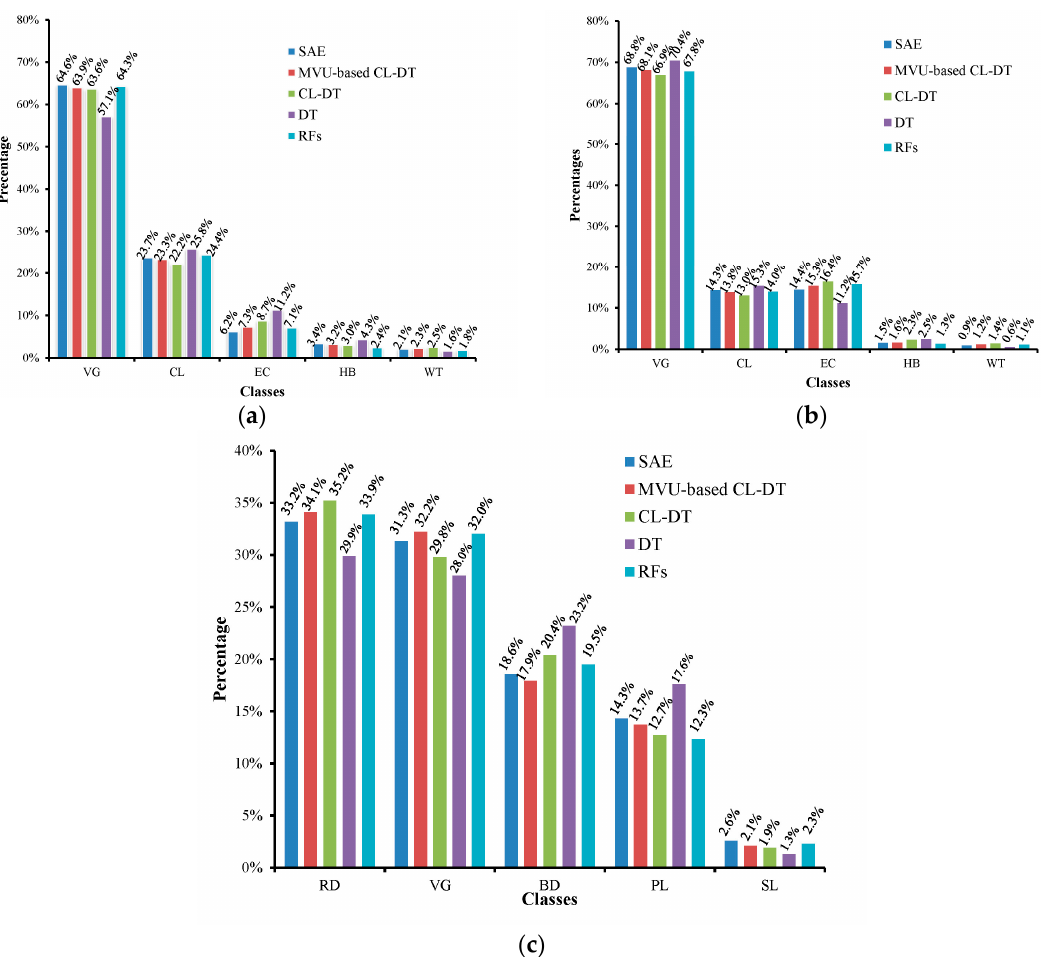
Figure 15. Comparison of the proportion of classes retrieved by different methods in: the first test area ( a ); second test area ( b ); and third test area ( c ).